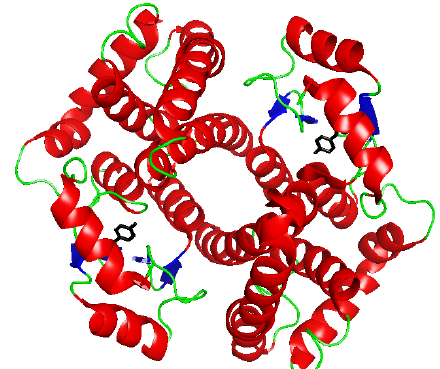
Figure 1. Ribbon diagram of human GSTP1-1 (PDB file 1PKW) [15]. In black the Tyr residue initially proposed as involved in the activation of glutathione